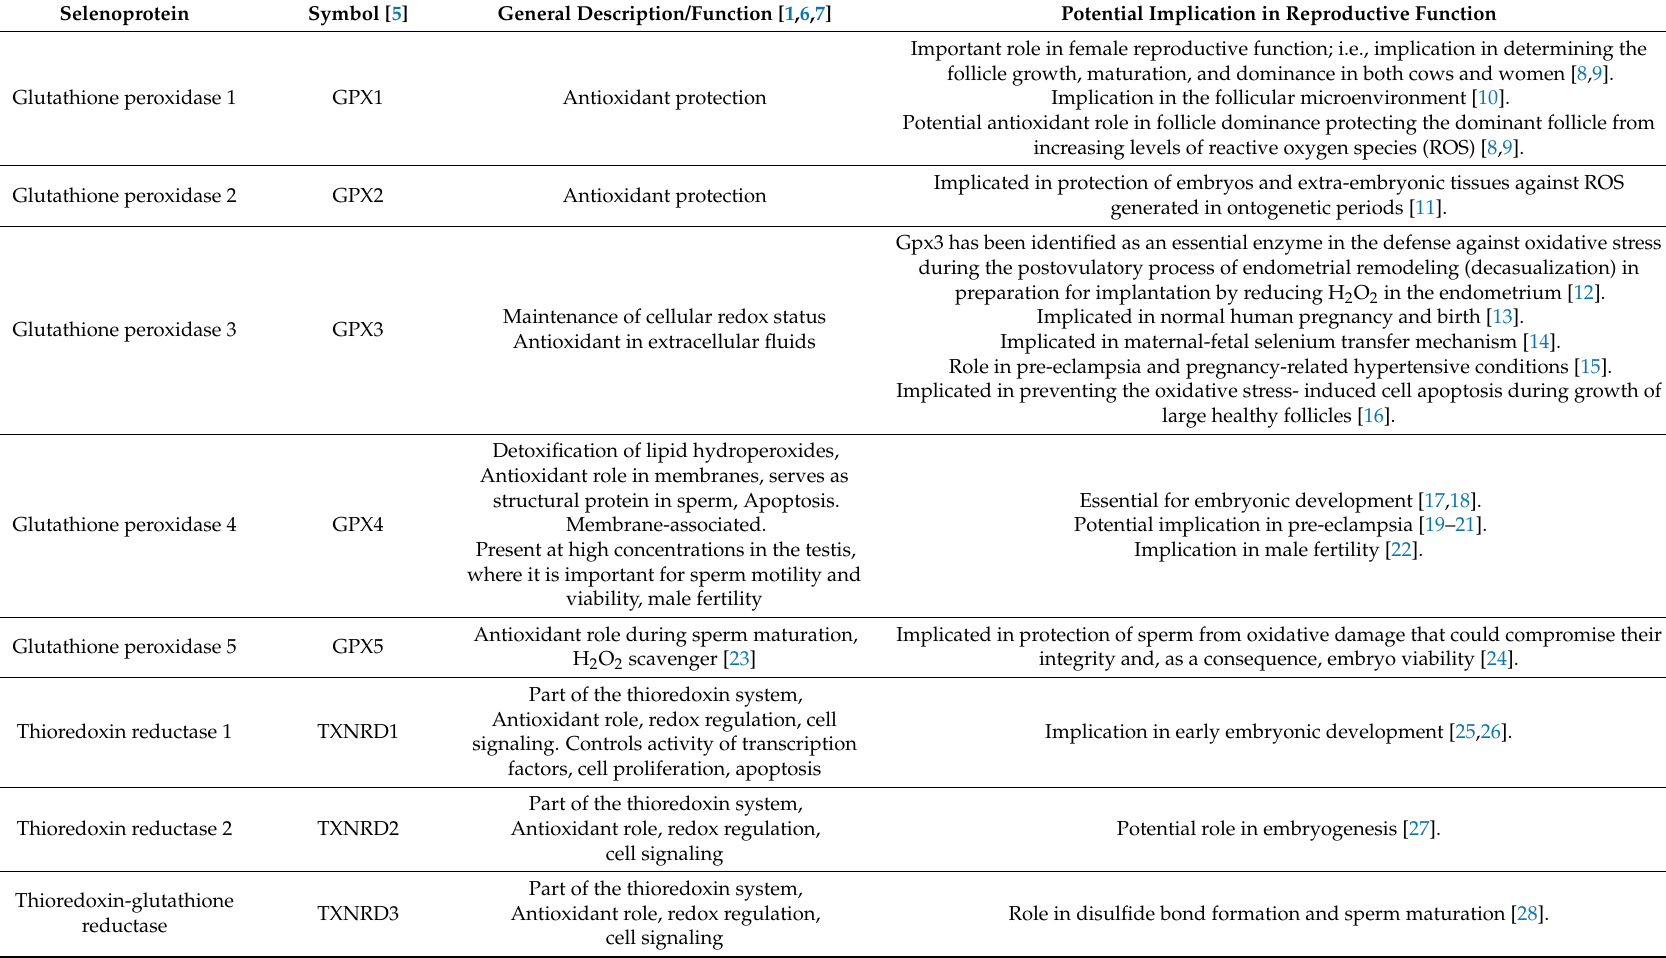
Table 1. Brief description of select mammalian selenoproteins having implication/role in fertility, reproduction, and